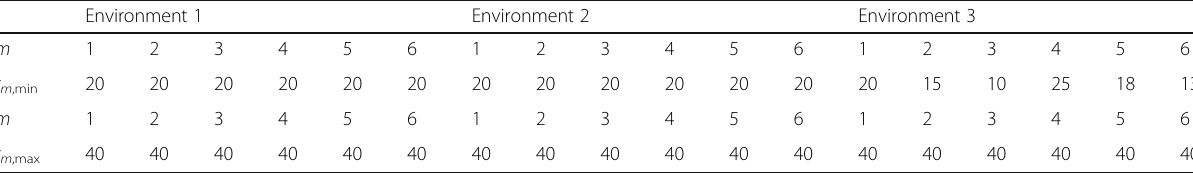
Table 1 Optimal performance obtained by OPMPD approach Environment 1 Environment 2